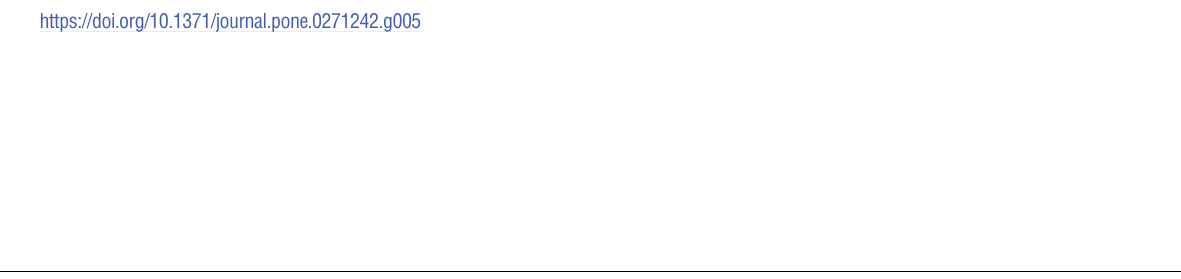
PLOS ONE | https://doi.org/10.1371/journal.pone.0271242 August 5,